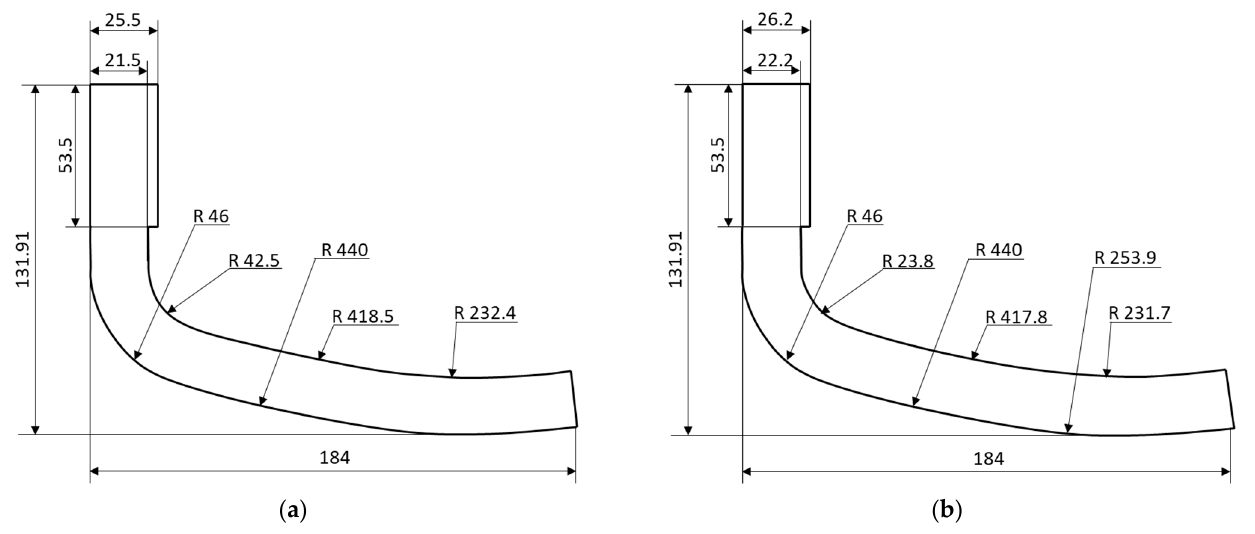
Table 10. Properties of glass fibre material used in the prosthesis simulations. All moduli are in MPa and Poisson’s ratios are dimensionless. The coordinate system considered is the local one. E 1 E 2